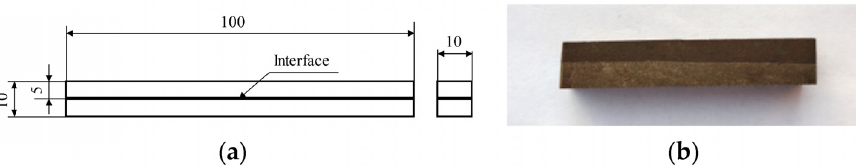
Figure 5. Samples for bending tests: ( a ) schematic drawing and ( b ) physical photo.